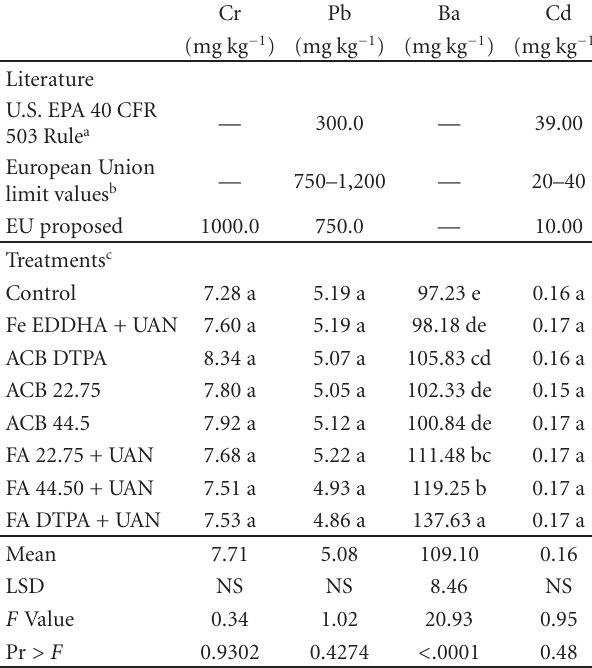
Table 6: SoilCr, Pb, Ba, and Cd levels in a Doak sandy loam amend- ed with industrial byproducts.